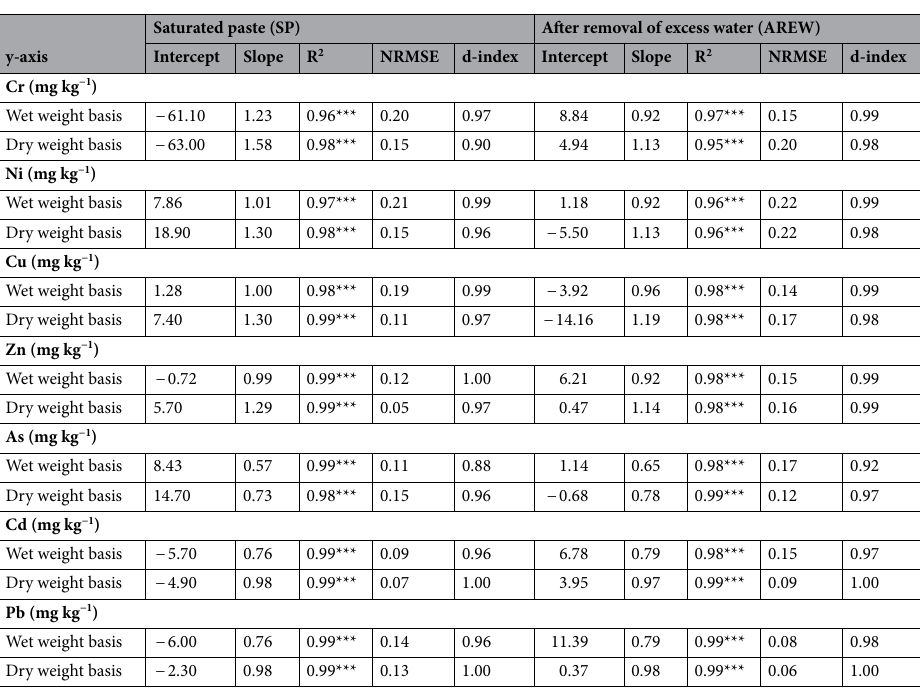
Table 3. Statistical parameters of the linear regression between metal concentrations in soils oven-dried at 105 °C (x-axis) and soils under different moisture conditions by pXRF measurements (y-axis). Samples were grouped as ‘saturated paste’ (SP), and ‘after removal of excess water’ (AREW), with moisture content ranging from 17.6 ± 1.8 to 30.7 ± 0.8% and 9.9 ± 1.8 to 23.9 ± 1% based on wet weight. ***Significant at P <